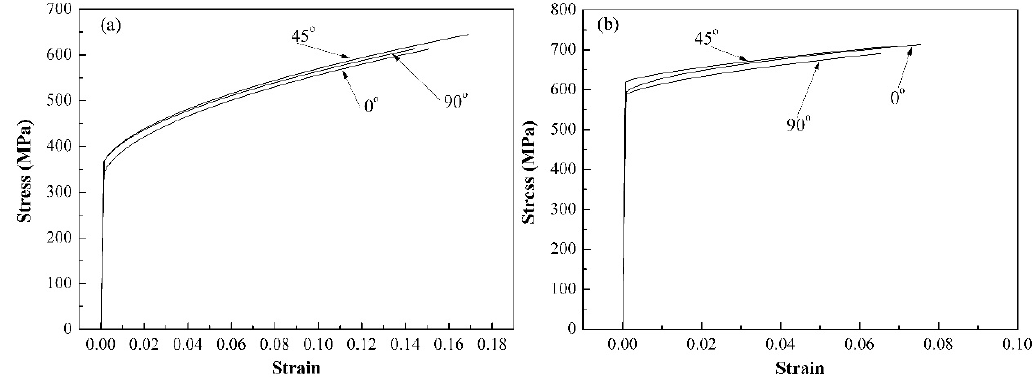
Figure 6. True stress-strain curves of the 7050 aluminum alloy at different tensile directions ( a ) as-quenched; ( b ) over-aged. Table 1. Mechanical properties of the 7050 aluminum alloy under different heat treatment conditions. Heat Treatment As-Quenched Over-Aged Tensile Directions 0°